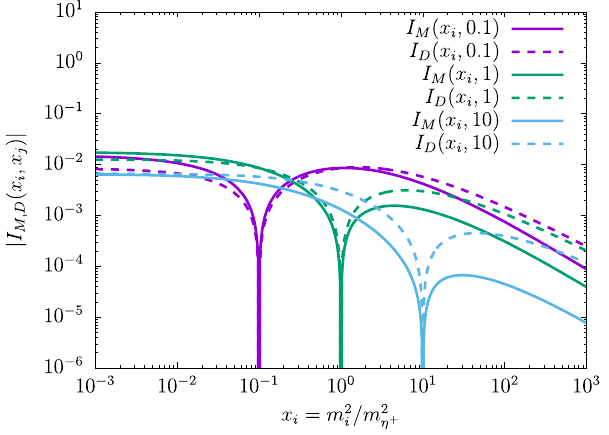
=m 2 is j (cid:17) +